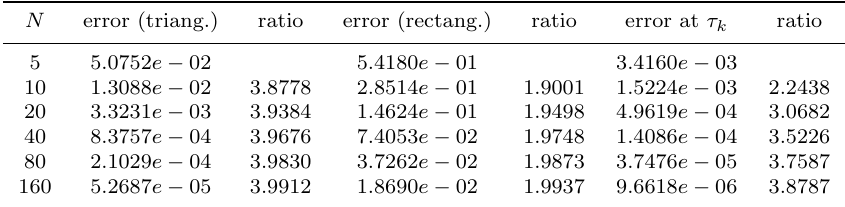
Table 2. Comparison of numerical results for Example 2. N error (triang.) ratio error (rectang.) ratio error at τ k